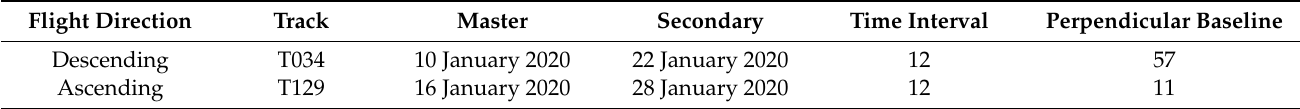
Table 2. Coseismic interferometry pairs.